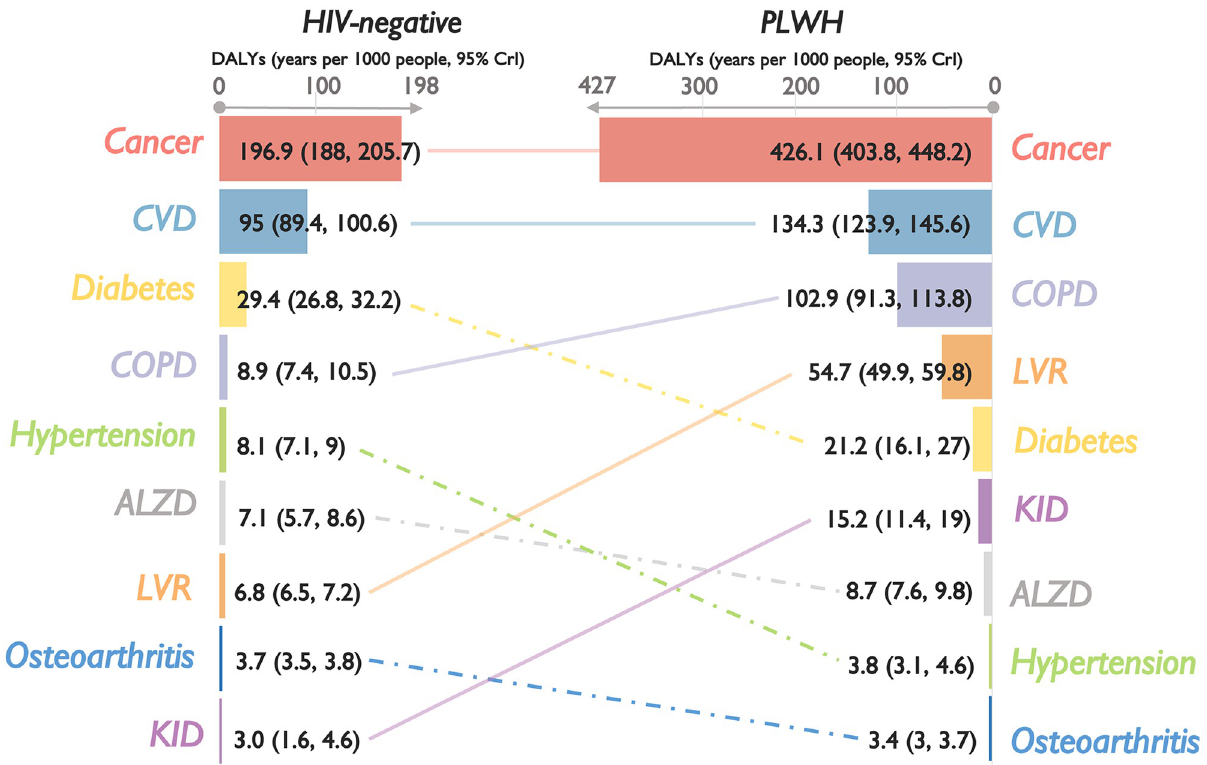
Fig 3. Cumulative YLDs (2008–2012) per 1000 people, with 95% credible intervals, associated with nine selected chronic comorbidities, ranked from highest to lowest, by HIV status in British Columbia, Canada. Note: PLWH: people living with HIV; YLDs: years of healthy life lost due to disability; 95% CrI: 95% credible intervals; ALZD: Alzheimer’s and/or non-HIV-related dementia (denominator included only individuals aged 40 years and older); Cancers: non-AIDS-defining cancer; COPD: chronic obstructive pulmonary disease (denominator included only individuals aged 35 years and older); CVD: cardiovascular diseases; KID: kidney diseases; LVR: liver diseases. Horizontal scales differ for each graph and between PLWH and HIV-negative controls for illustration purposes.